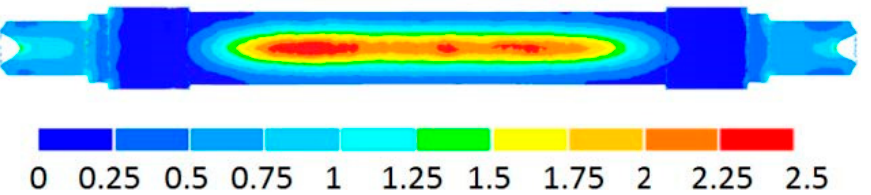
Figure 9. Damage function distribution in a rail axle produced by two-stage CWR [9] (Reprinted from ref. [9]).